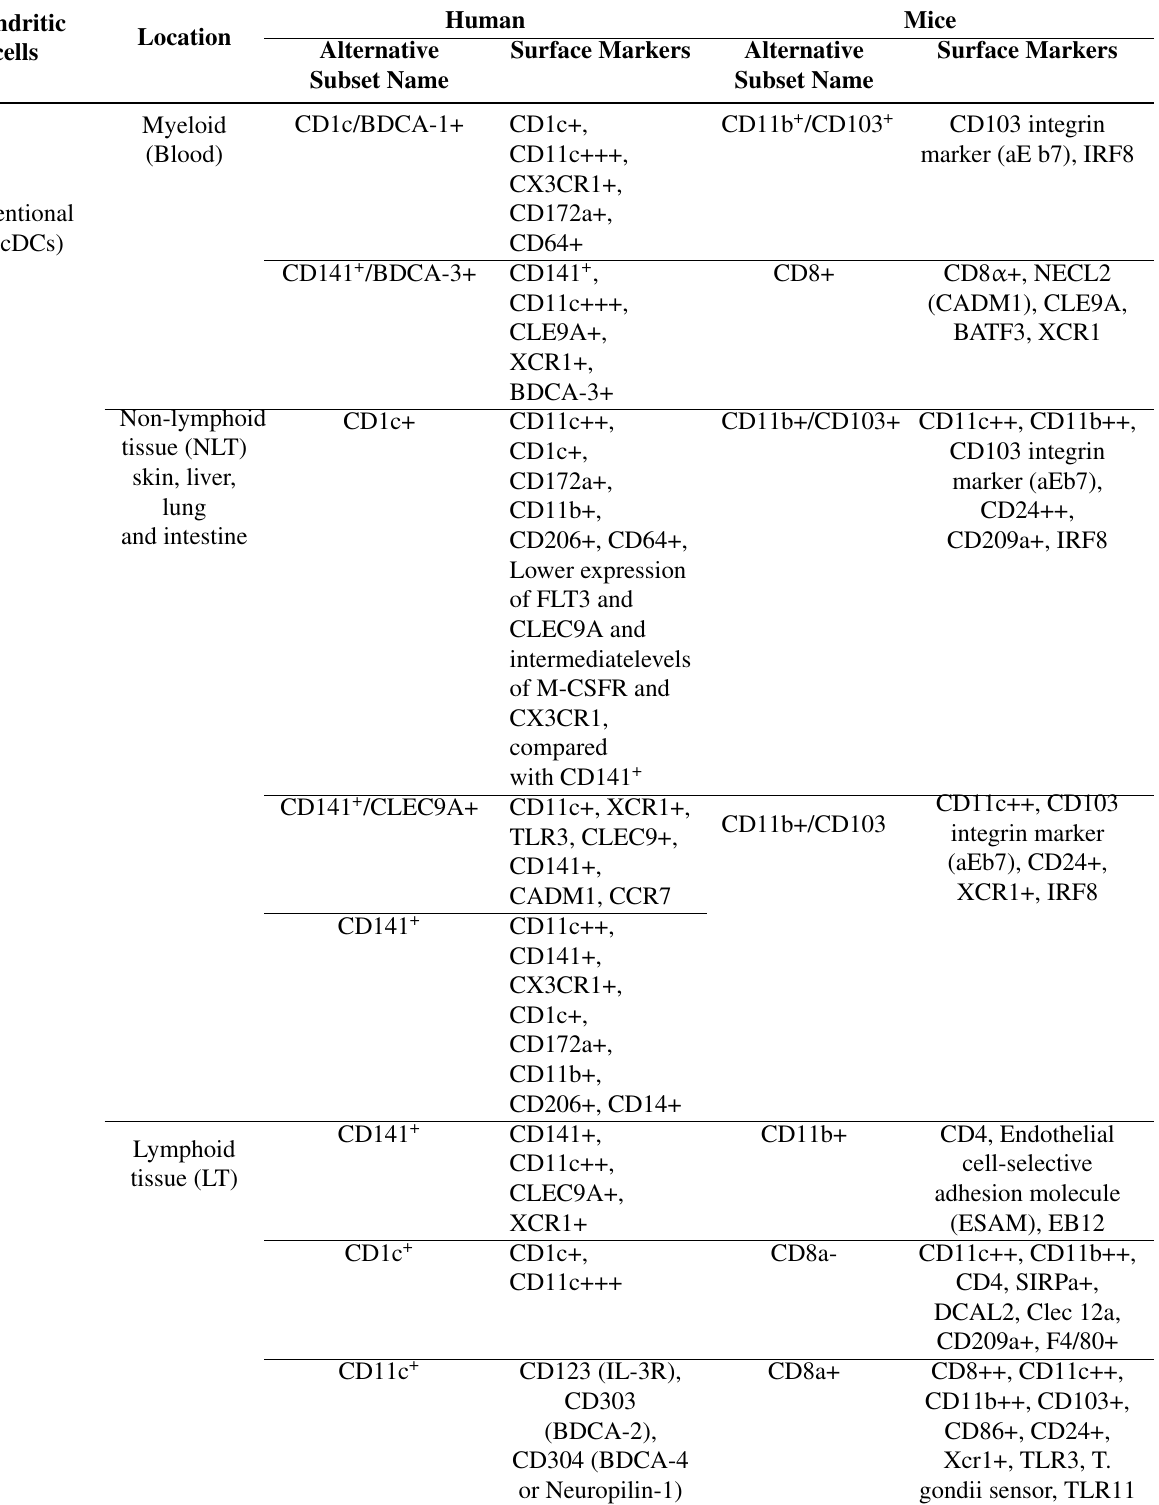
Table 1. DC development, subsets and lineage-specific